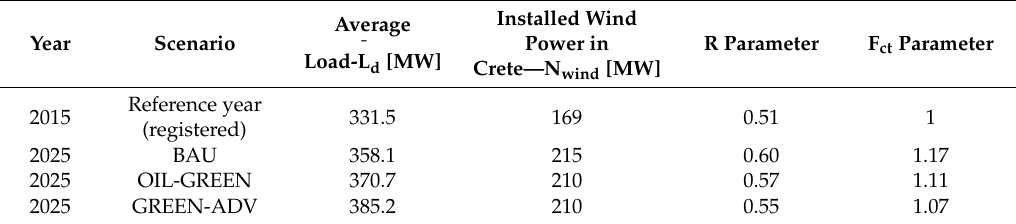
scenario for the reference year 2015 and the forecasted year 2025.